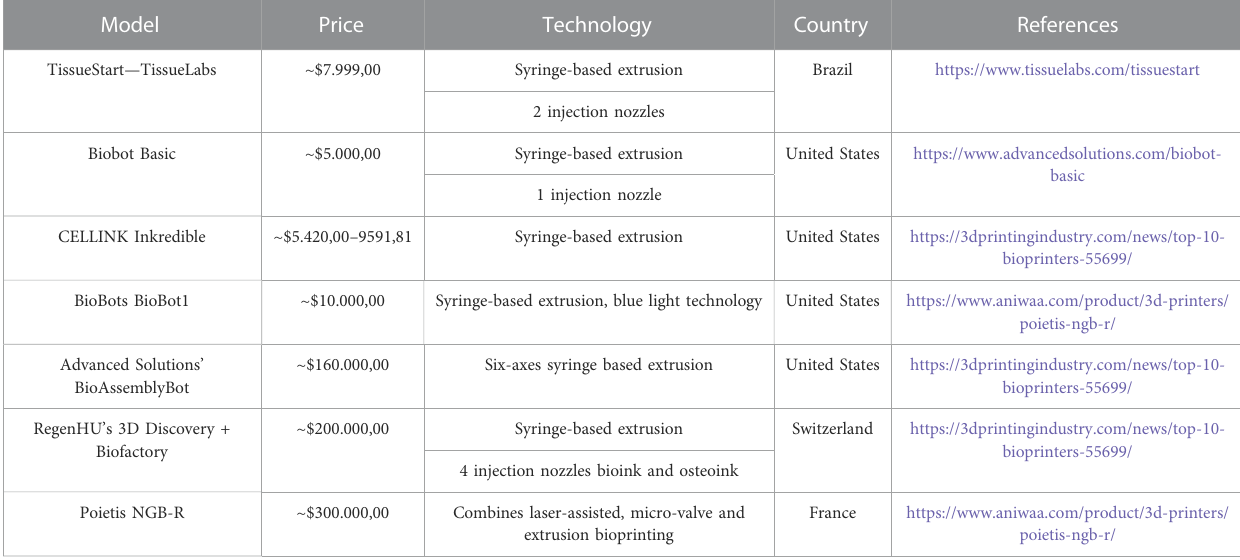
TABLE 4 Comparative list of commercially available bioprinters per mechanism and customized prototypes